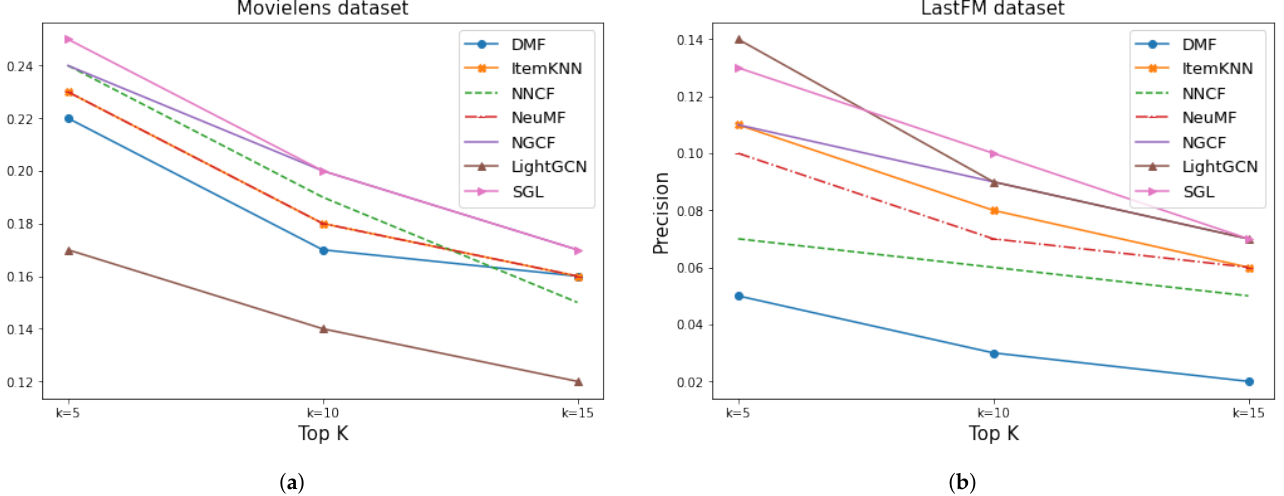
Figure 12. Results of precision for Movielens and LastFM. ( a ) MovieLens precision. ( b ) LastFM